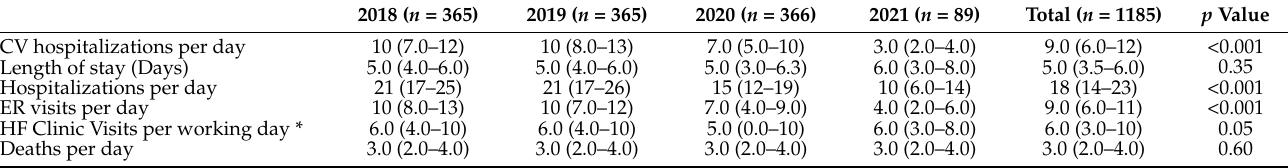
Table 3. Medical service usage during the pandemic (2020–2021) and previous years in the HF